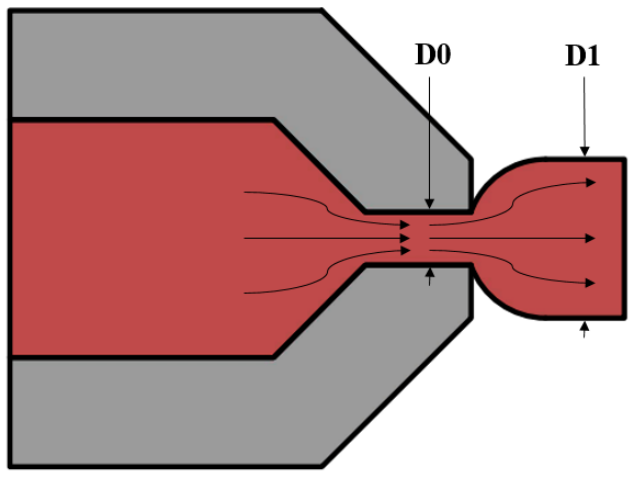
Figure 5. Schematic figure of the polymer expansion during